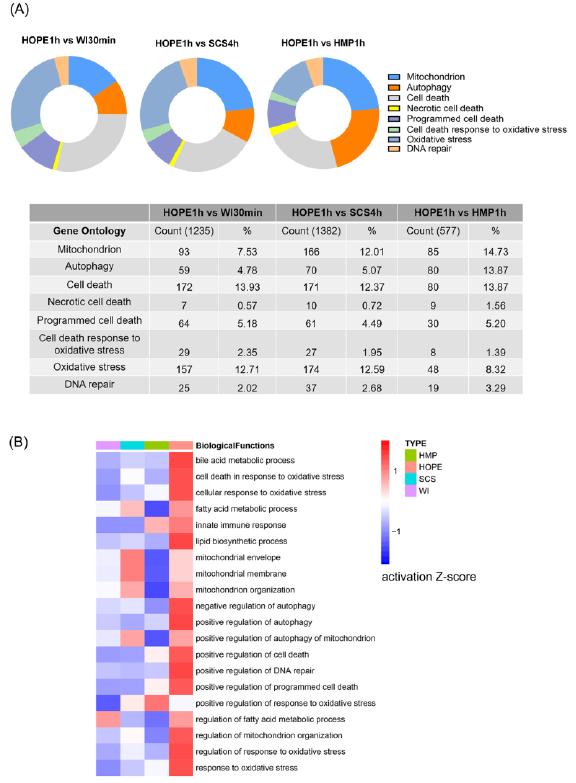
Figure 3. HOPE-regulated transcriptomic gene in DCD liver targeted mitochondrial bioenergetics, autophagy, and cell death. ( A ) The pie chart represents the most common gene ontology clusters that were altered in response to hypoxia-ischemic injury; tables represent the percentile change in gene ontology from the total genes in the array. ( B ) Heat map comparison analysis shows changes in gene expression related to a variety of biological functions across observations in multiple datasets. The 20 rows (biological function) with the highest total absolute z-scores across the set of observations were sorted. Four columns designate gene expression signatures in the four groups: WI 30 min, SCS 4 h, HMP 1 h, and HOPE 1 h. The activation z-scores for biological functions are displayed using a gradient from dark blue to red for activation z-scores. ( n = 3).